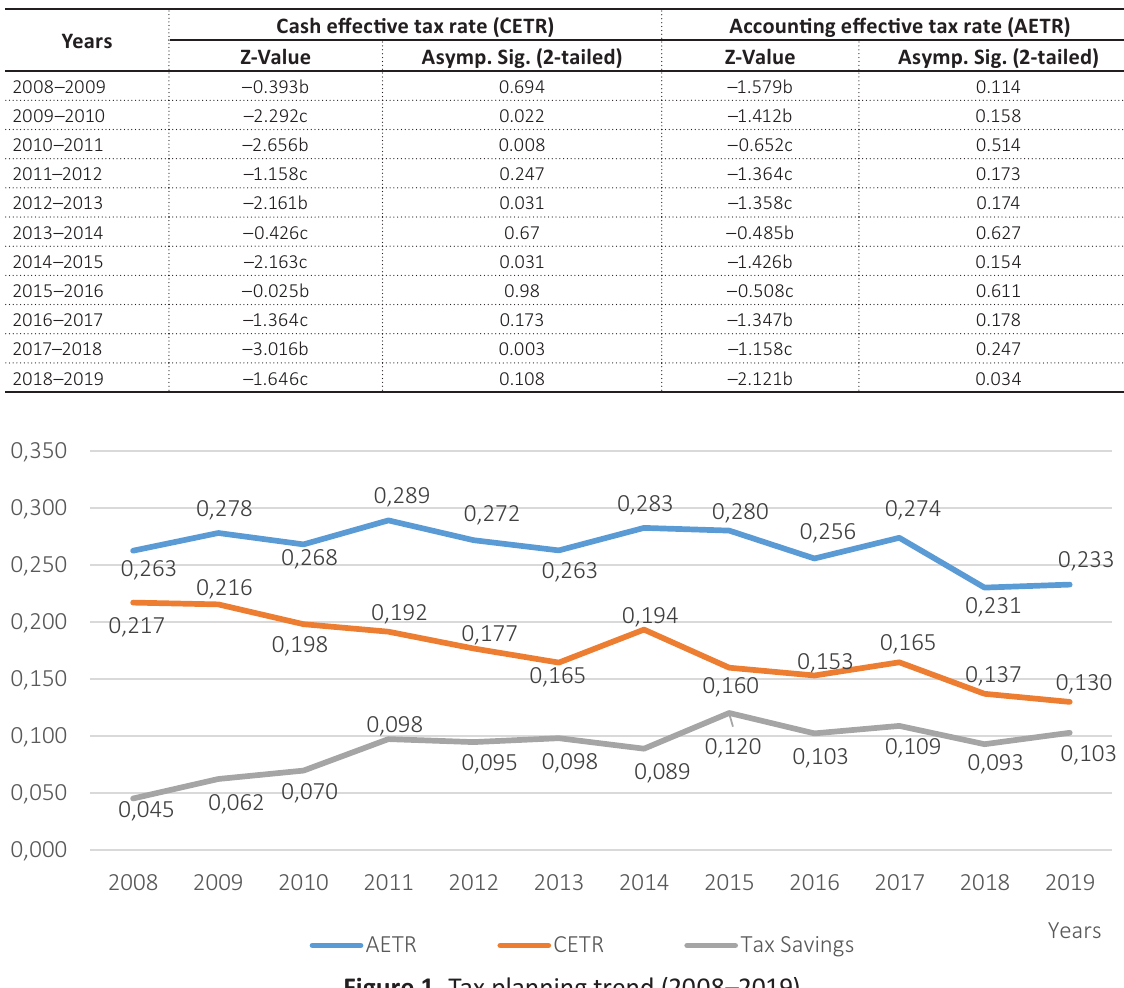
Table 1. Wilcoxon signed-ranked test